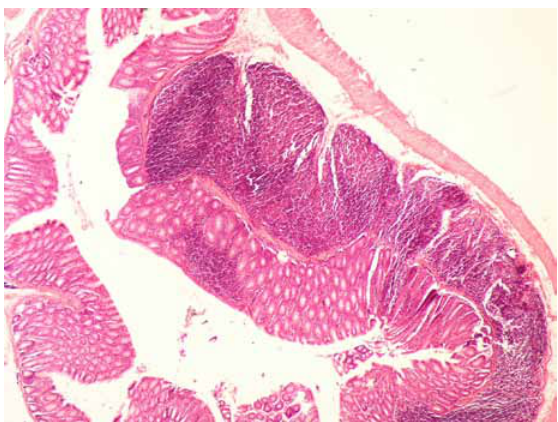
Figure 5. Photomicrography. Hyperplasia of intestinal lymph nodes. Stained by Van Gisone. Increase.